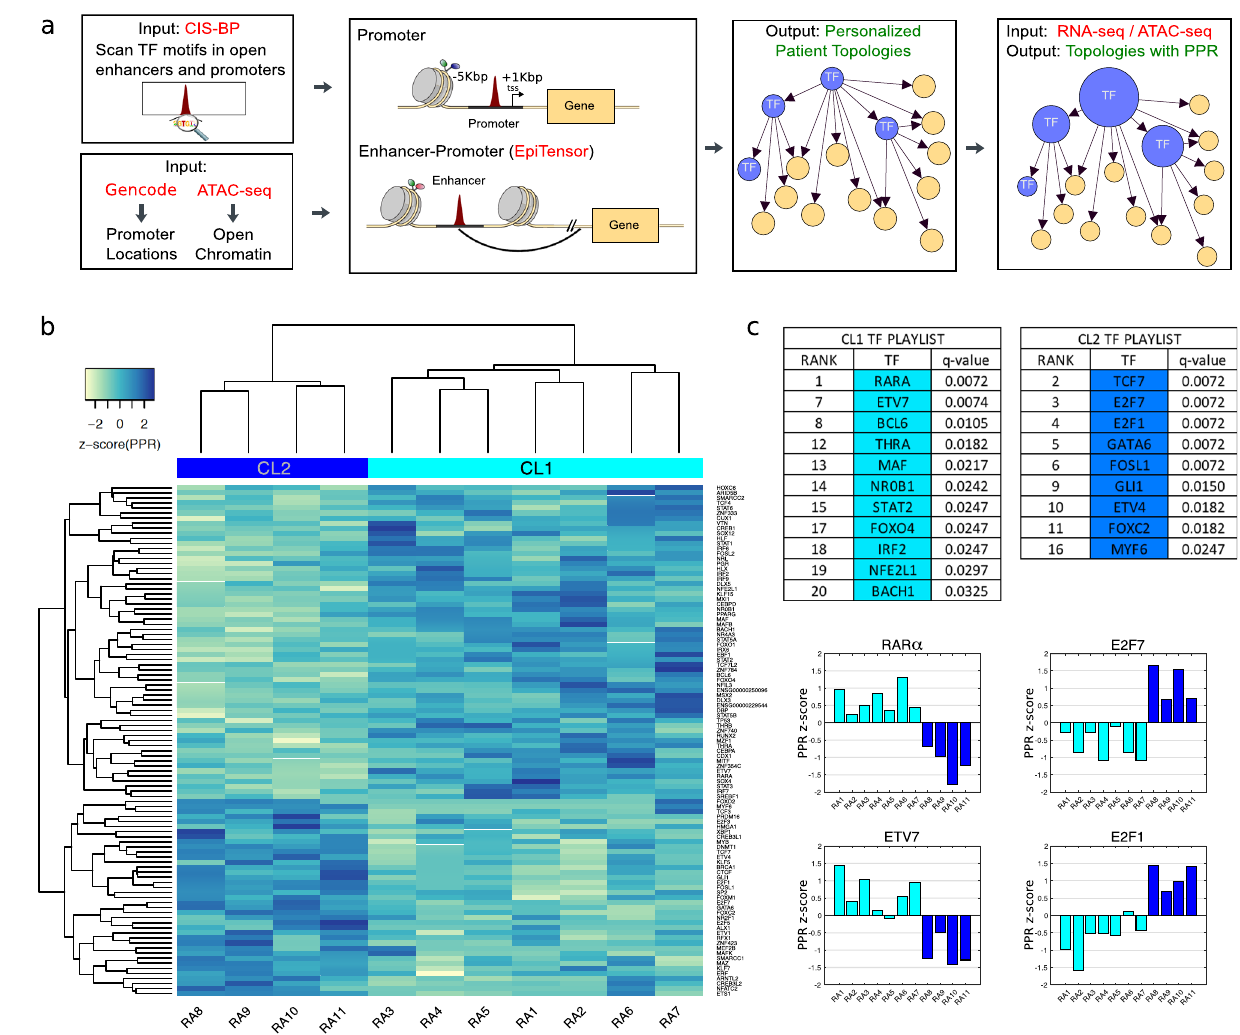
Fig. 1 | Individual transcriptional gene regulation networks for Rheumatoid ArthritisFibroblast-likeSynoviocytesallowforcelllinestrati fi cationbasedon global TF regulatory differences. a Construction of cell line speci fi c global tran- scriptional gene regulation networks using the Taiji Integrative Pipeline with RNA- seq and ATAC-seq data. Ranking of TFs using Personalized PageRank (PPR). b Cell